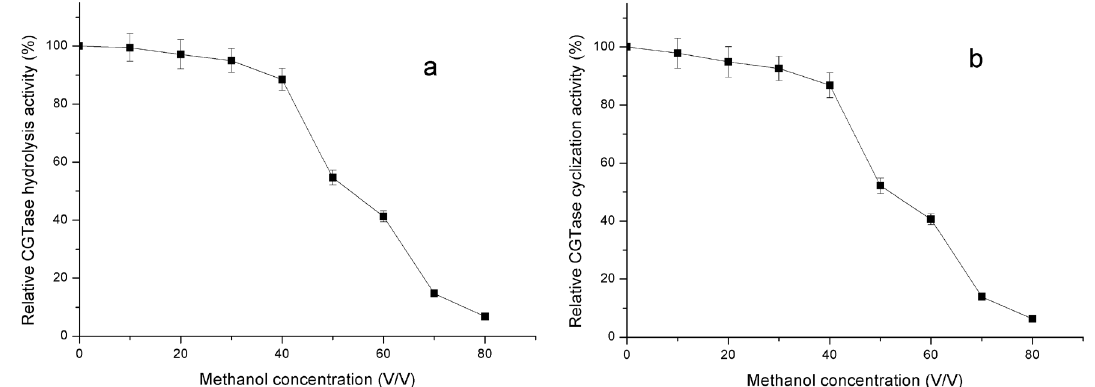
Figure 2. Inhibitory effect of methanol on CGTase hydrolysis activity ( a ) and on CGTase cyclization activity ( b ).